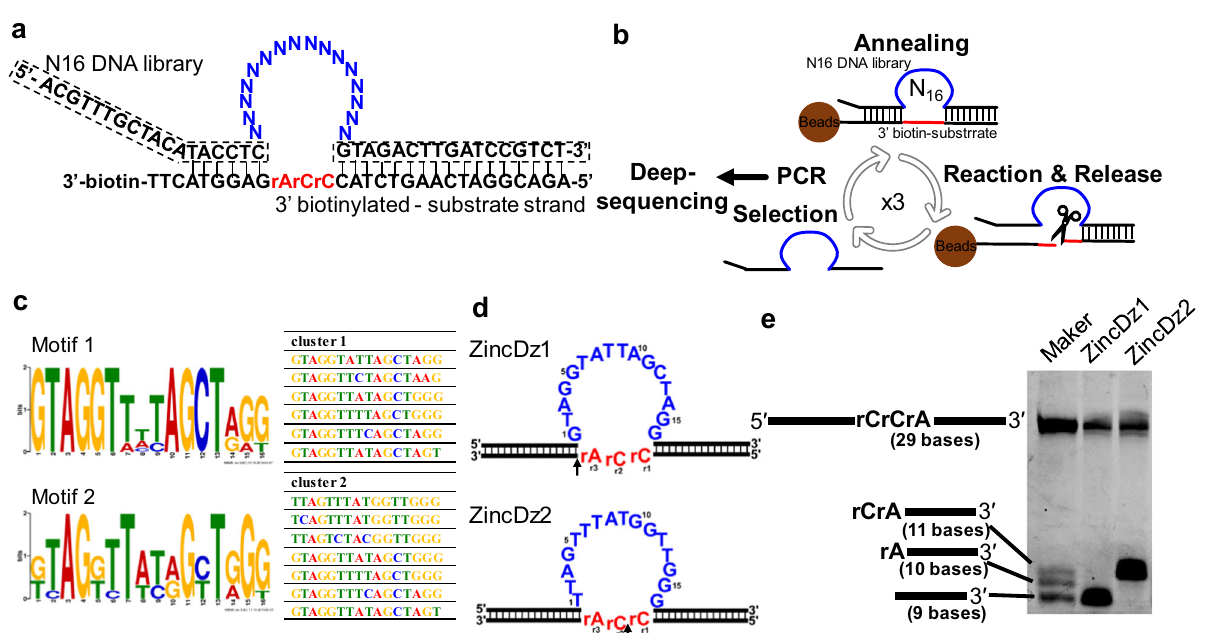
Fig. 1 RNA-cleaving DNAzymes obtained by in vitro selection. a The sequences of DNA library (including 16-nt randomized region) and 3 ′ -biotinylated substrate used in the in vitro selection experiment. The arm sequences of the DNA library, corresponding to primer sequences for ampli fi cation, are indicated with the dotted line. The catalytic core region and the core substrate RNA region are shown in blue and red, respectively. b The in vitro selection procedure used in this study. In each cycle, the DNA library sequences that exhibited cleavage activity were released into the solution. The reaction was carried out in a reaction buffer, 50 mM HEPES, pH 7.5, 150 mM NaCl, and 1 mM ZnCl 2 at 37 °C for 30 min. The catalytic core region and the core substrate RNA region are shown in blue and red, respectively. c Two consensus sequences, motif 1 and motif 2, enriched by the in vitro selection, as identi fi ed with the MEME suite software. d The proposed secondary structures of ZnicDz1 (motif 1) and ZincDz2 (motif2). e The 3 ′ -FAM labeled substrates were cleaved by ZincDz1 or ZincDz2 and analyzed by denaturing PAGE gel (20% polyacrylamide/7 M urea) with an alkaline-hydrolyzed substrate maker (lane 1). ZincDz1 and ZincDz2 cleave the substrate at the sites indicated by the arrows depicted in d